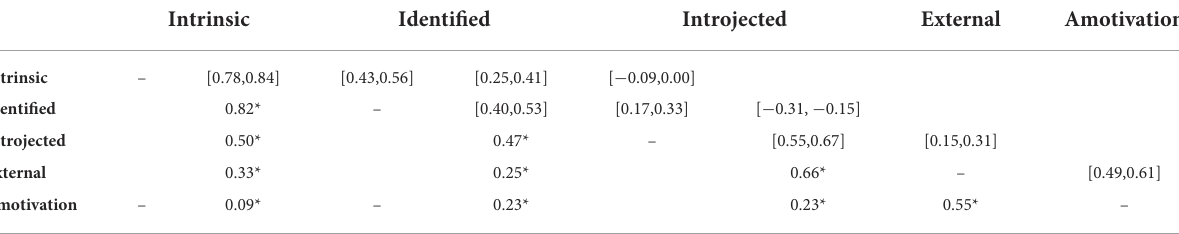
TABLE 8 Study 2 correlations among the five motivation subscales (below the diagonal) and 95% confidence intervals (above the